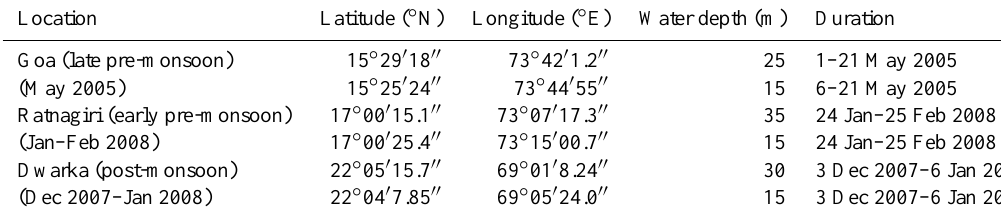
Table 1a. Details of wave data.